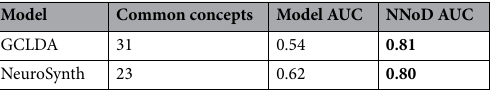
Table 2. Models performance comparison on enriched